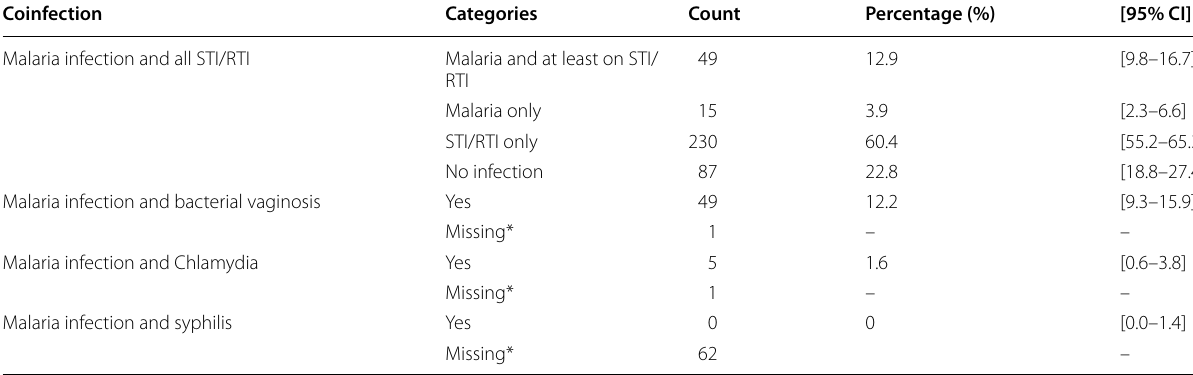
Table 3 Prevalence of malaria and curable STI/RTI coinfection among first antenatal care attendees in the Yako health district, Burkina Faso ( n 402) =